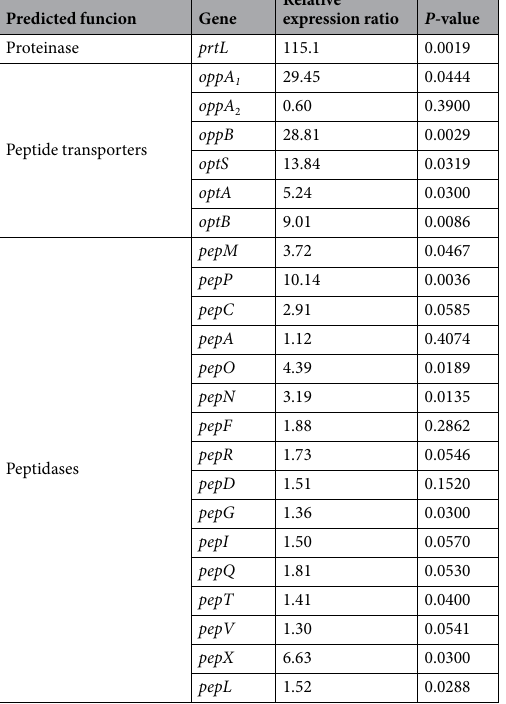
Table 2. Relative expression ratio of genes related to the proteolytic system of L . delbrueckii subsp. lactis CRL 581 during growth in CDM versus CDM plus